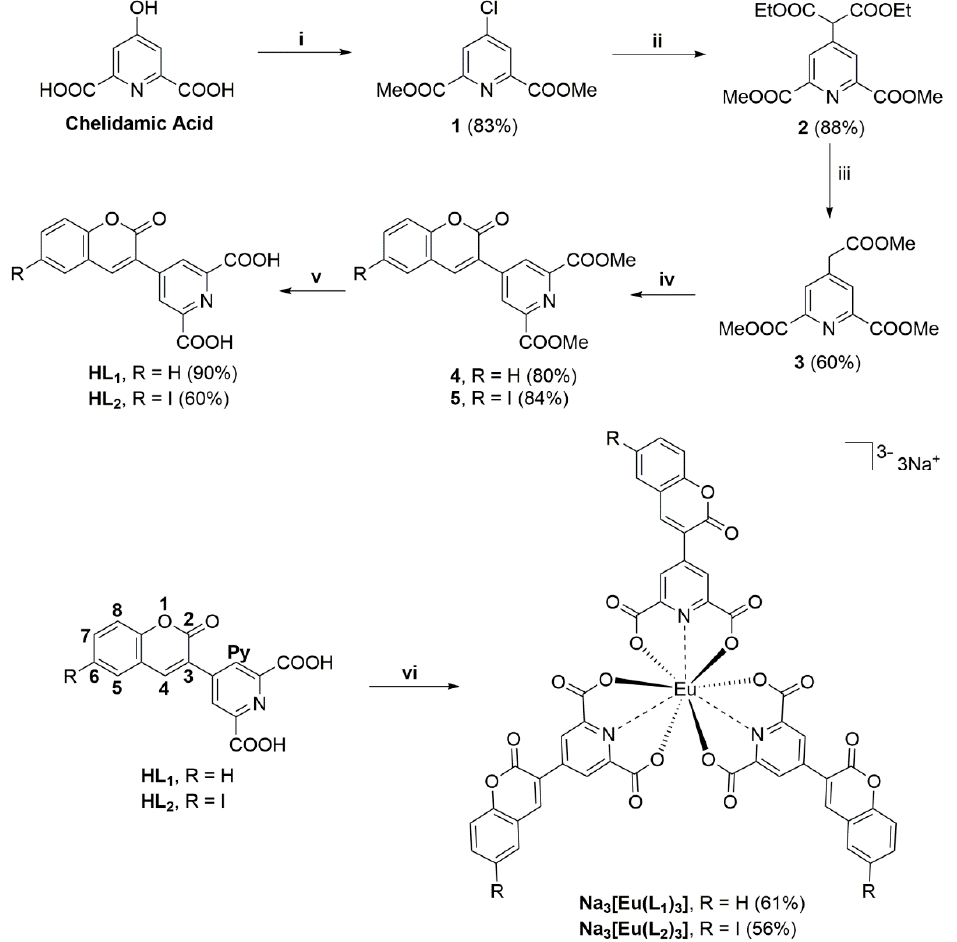
Scheme 1. Synthetic pathway for the synthesis of ligands HL 1 and HL 2 and tris complexes Na 3 [Eu(L 1 ) 3 ] and Na 3 [Eu(L 2 ) 3 ] . (i) SOCl 2 , DMF(cat) and then MeOH; (ii) diethylmalonate, Cs 2 CO 3 and DMSO, 100 °C; (iii) NaOH/MeOH, HCl then MeOH reflux; (iv) salicylaldehyde or iodo-salicylaldehyde, DMSO, piperidine, 90 °C; (v) MeOH/H 2 O = 3/1, NaOH then HCl;